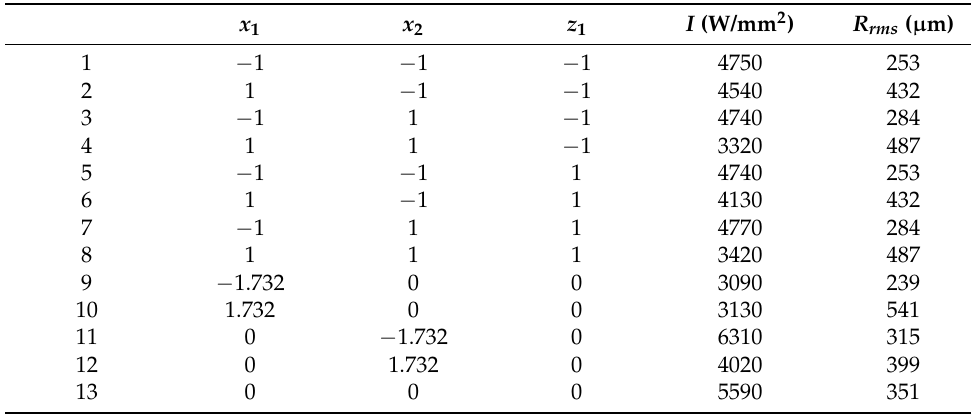
Table 3. Experiments of designs in coded levels and simulated